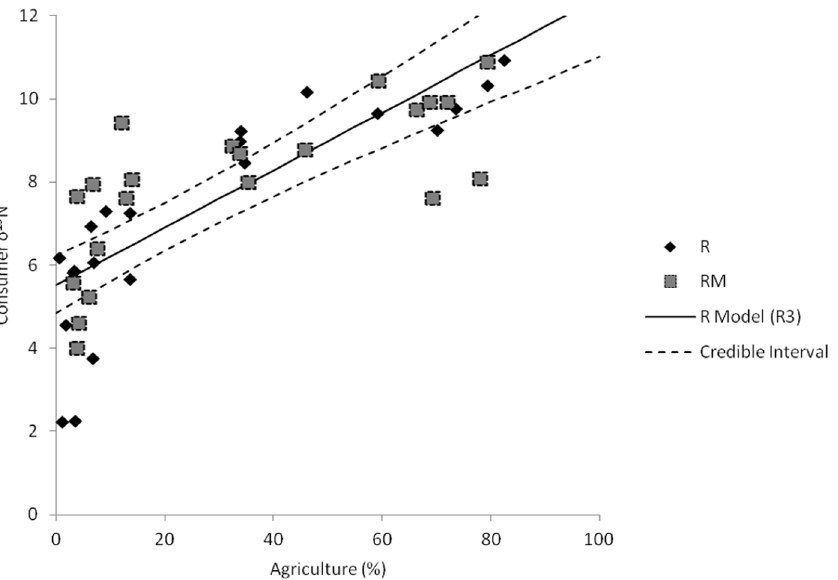
Figure 4. Relationship between watershed agriculture and consumer tissue d 15 N. Squares are rivermouth (RM) consumers, diamonds are river (R) consumers. The lines represent the linear relationship between agriculture and consumer d 15 N at the R sites (with 95% credible interval). The linear relationship for the RM sites was not statistically significant (parameters in Table 2).